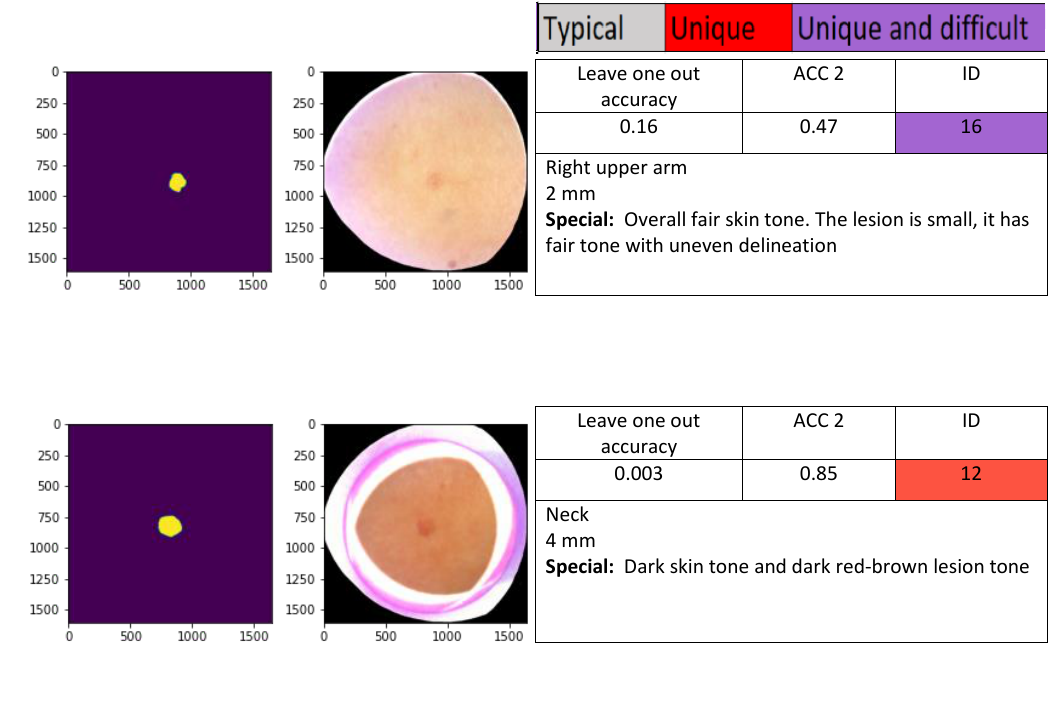
Special: Overall fair skin tone. The lesion is small, it has